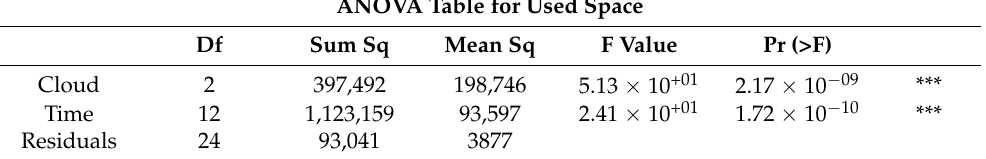
Table 3. ANOVA Table for instance utilized data on clouds .